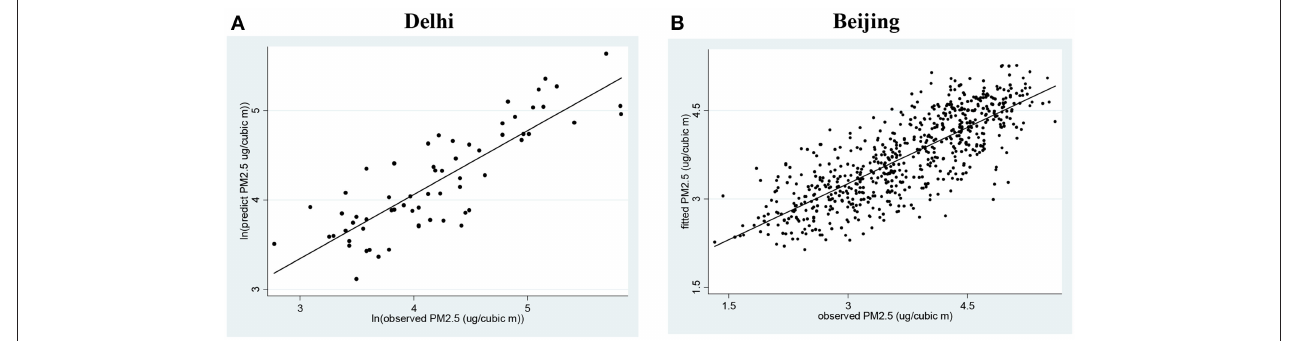
FIGURE 1 | Hourly observed and predicted PM 2.5 in Delhi and Beijing. (A) Based on 2014–15 PM 2.5 data monitored at American Embassy in New Delhi, India. (B) Based on 2008–2015 PM 2.5 data monitored at American